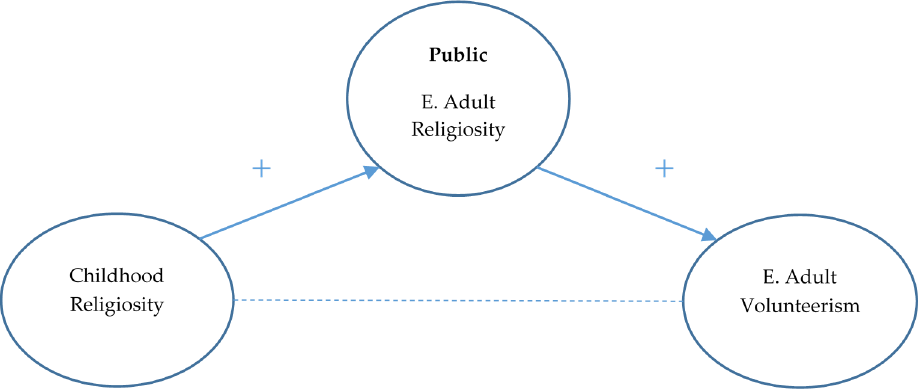
Figure 2. Mediating effects of public emerging adult religiosity on rates of volunteerism.